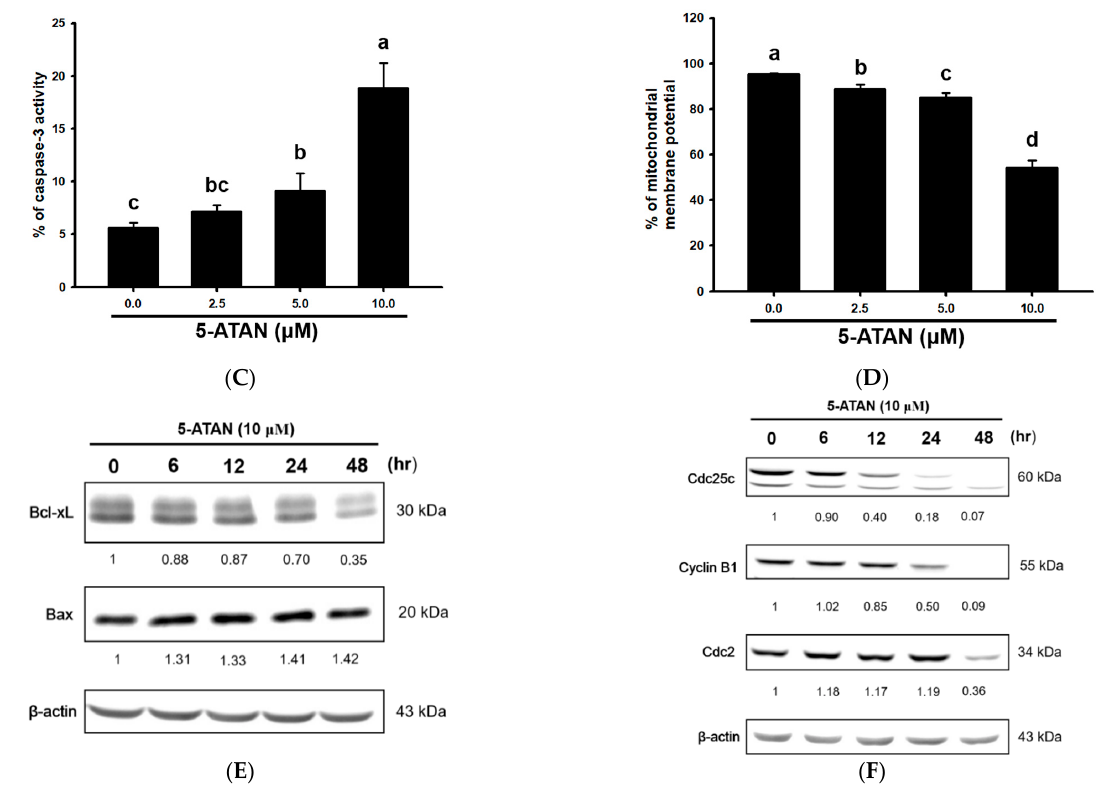
Figure 3. Effects of 5-ATAN on the mitochondrial pathway and cell cycle checkpoint protein expres- sion in PC-3 cells. Cells were treated with various concentrations of 5-ATAN for 48 h or 10 µ M of 5-ATAN for different time periods. ( A ) Caspase-3 activity. ( B ) Mitochondrial membrane potential was then analyzed by flow cytometry. ( C , D ) Data were expressed as mean ± SD of three determinations presented in the bar graph and analyzed statistically using ANOVA and Duncan’s test. Different letters represent statistical differences among treatments, p < 0.05. The protein expression of ( E ) Bcl-xL and Bax, ( F ) Cdc25c, Cyclin B1, and Cdc2 were analyzed by Western